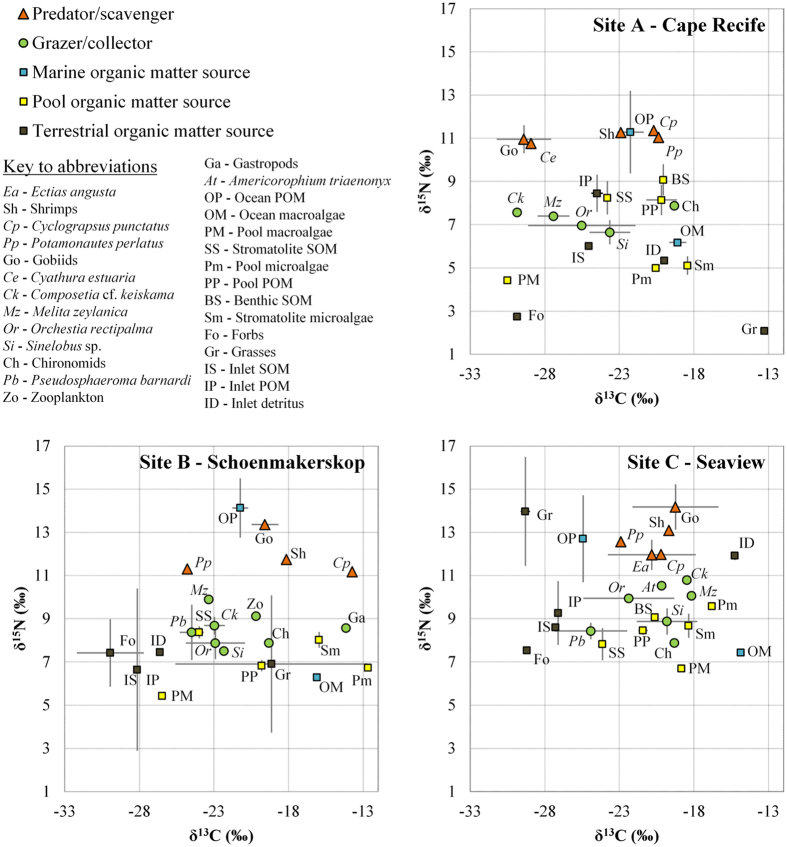
Mean (±SD) carbon and nitrogen stable isotope (‰) biplot of all measured components at the three sites along the South African coastline during August 2015.Epifaunal and infaunal samples are combined for respective species. Chironomid samples across the three sites were combined during processing to achieve a single, multi-site value.